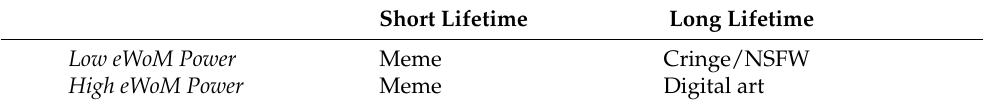
Table 12. Categorization of the posts associated with the lifespan template “Revived”.